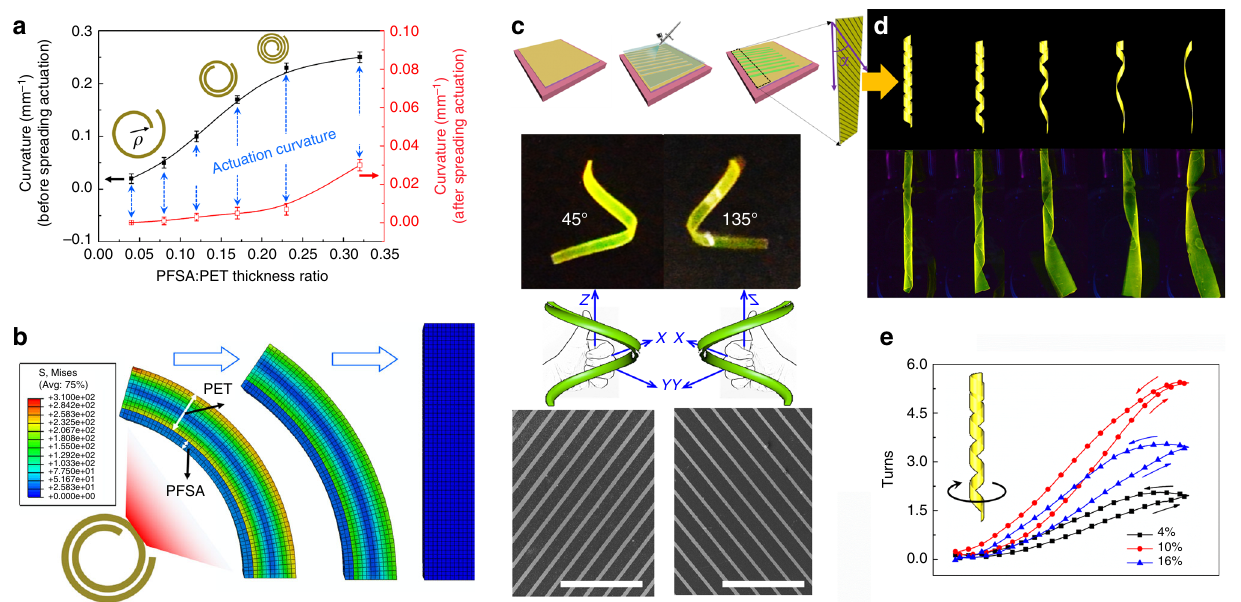
Fig. 4 PFSA-based helical actuation. a Plots showing the bending curvature for the 20 × 60 mm bilayer actuator depending on the ratio of the active-to- inner layer thickness. b FEA results of stress distribution associated with the bending actuation of bilayer actuator. c The scheme illustrating the preparation of the three-dimensional helical buckling with an active PFSA layer line. Photos and schematic illustration of the right-handed and left-handed deformation of the composite strips with an α of 45° and 135°. SEM images of aligned PFSA lines. (Scale bar is 400 µ m). d , e Schematic illustration, photographs, and time-dependent untwisting actuation of the helical strip before and after triggering by